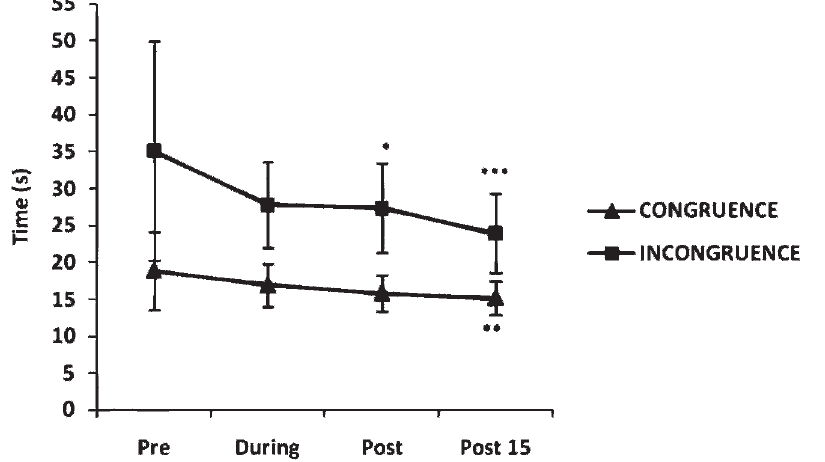
Figure 2 - Comparison of performance in the Stroop Test among different time points (means ¡ SD). * p , 0.05 compared to before exercise, ** p , 0.05 compared to before and during exercise, *** p , 0.05 compared to before and immediately after